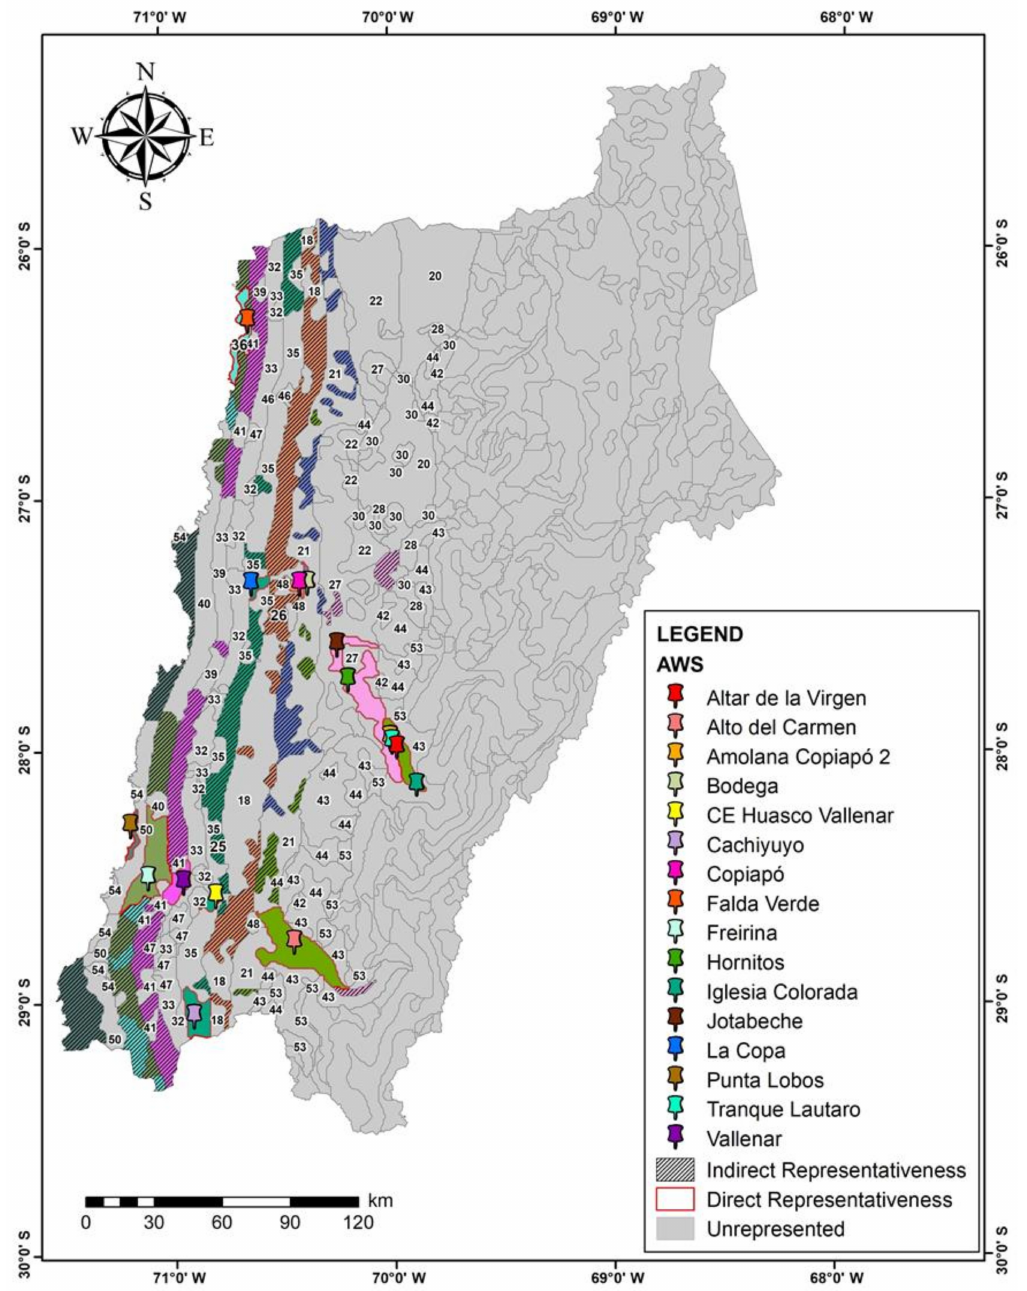
Figure 7. Cartography of automatic weather station (AWS) topoclimatic representativeness and that of adjacent